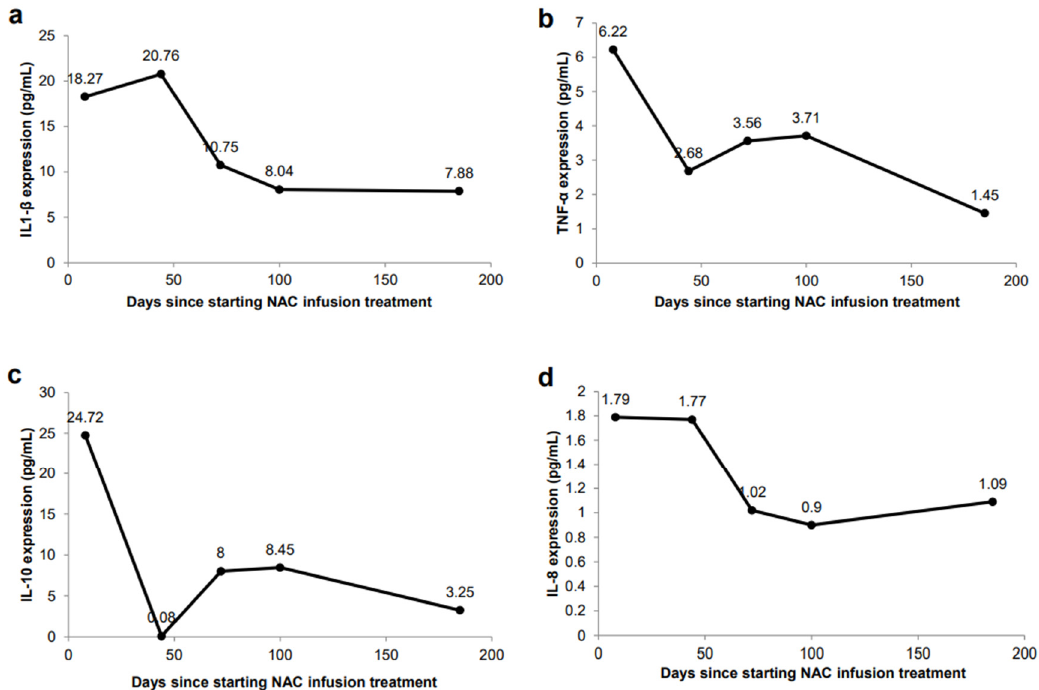
Figure 2. Changes in plasma cytokine secretion in response to NAC IV infusions. ( a ) IL-1 β expression (ELISA) in peripheral blood. ( b ) TNF- α expression (ELISA) in peripheral blood. ( c ) IL-10 expression (ELISA) in peripheral blood. ( d ) IL-8 expression (ELISA) in peripheral blood.